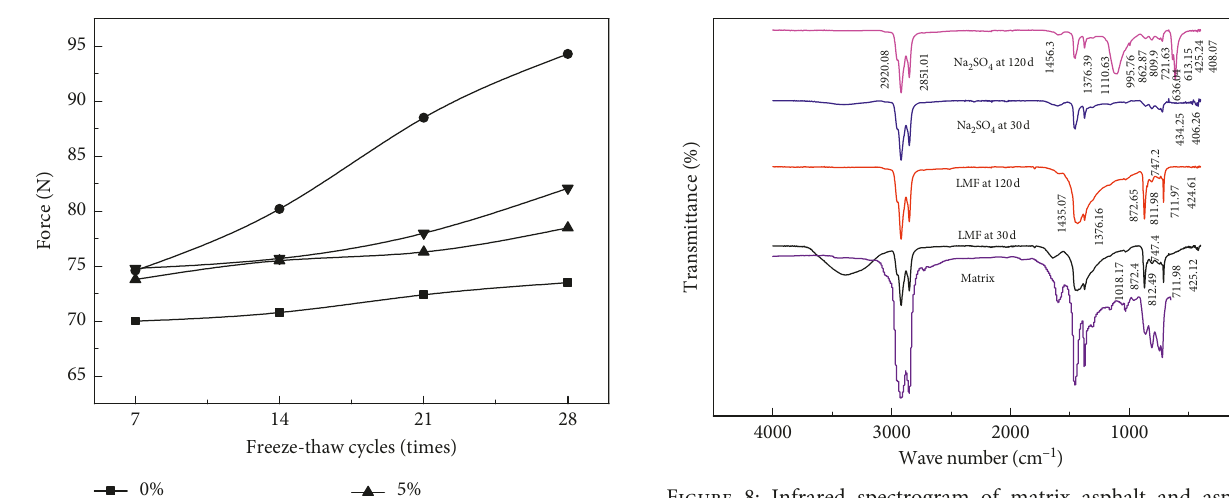
Figure 8: Infrared spectrogram of matrix asphalt and asphalt